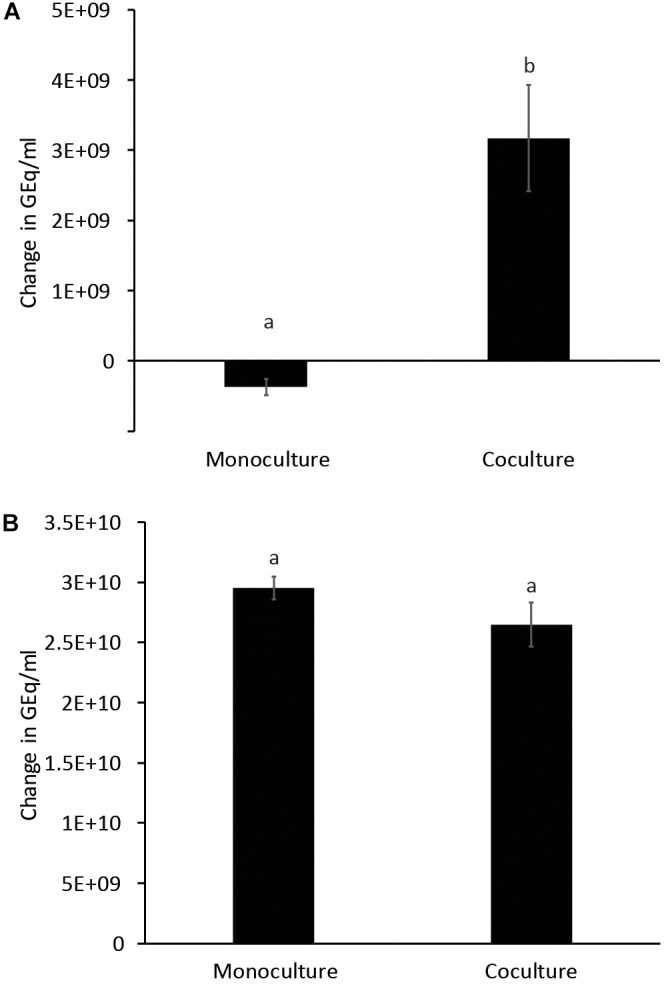
Growth of E. ramulus
(A) and B. thetaiotaomicron
(B) in cultures with 1% starch as carbon source. GEq, Genome equivalents. Change in Geq/ml between time 0 and 8 h. Results from independent experiments are presented in Supplementary Table S2. Different letters above bars indicate significant differences between type of culture at p < 0.05 according to LSD, data from 2 independent experiments (with 2–3 replicates each).